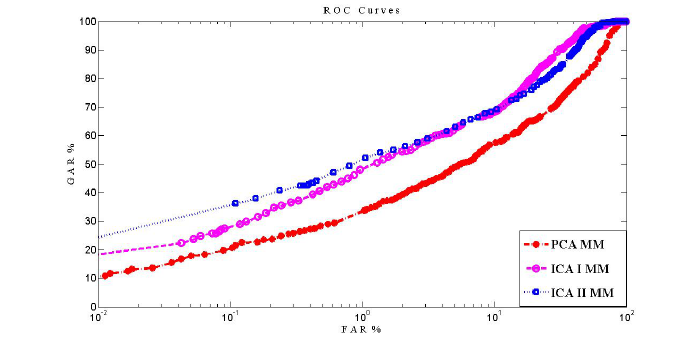
Figure 6. ROC curves for the proposed mixture model based approaches on Database II.